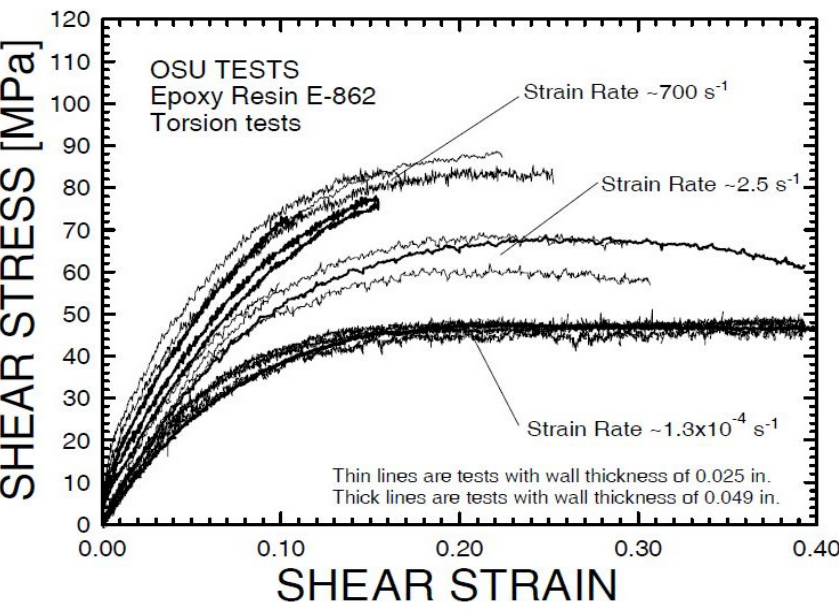
Figure 9. Shear stress-strain curve of Epoxy resin E − 862.